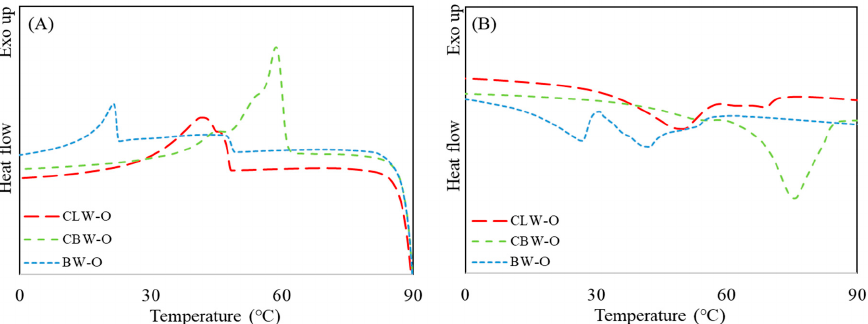
Figure 2. Heating ( A ) and cooling ( B ) thermal properties of oleogels with different wax types by DSC (CLW-O: candelilla wax-oleogel, CBW-O: carnauba wax oleogel, BW-O: beeswax